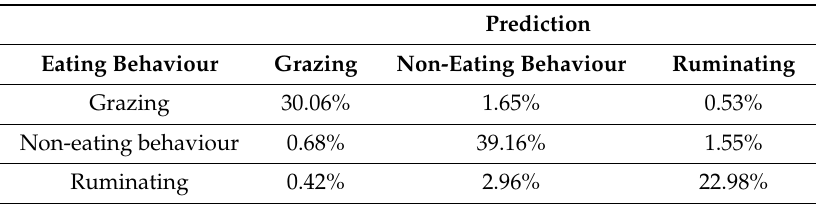
Table 5. Confusion matrix using collar data and 39 features to assess the performance of classification of specific eating behavioural activities based on random forest.